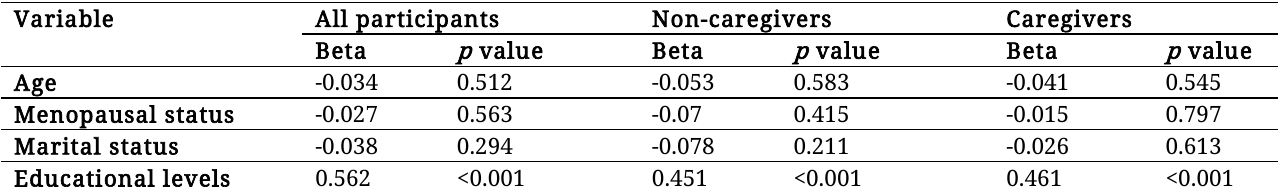
Table 4: Regression model with percent overall score as the outcome Variable